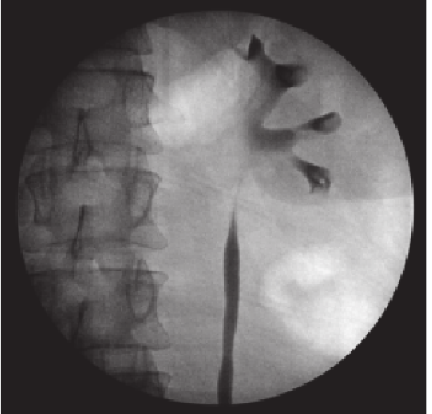
Figure 2: Retrograde pyelogram conducted at the time of the relook ureterorenoscopy. Note the absence of filling defects and the normal calibre upper